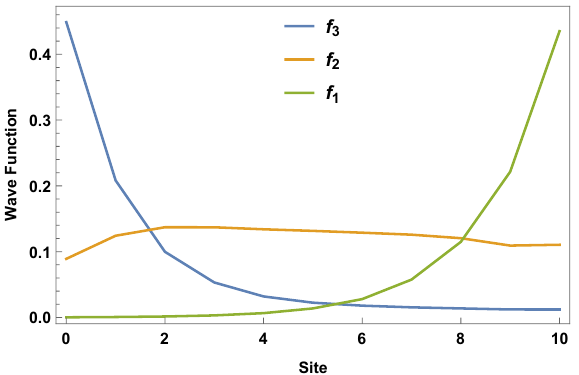
Figure 4. Average localization of the three zero mode wave functions in theory space. We display the medians of the wave functions f i de(cid:12)ned to be the three columns of eq. (3.11).